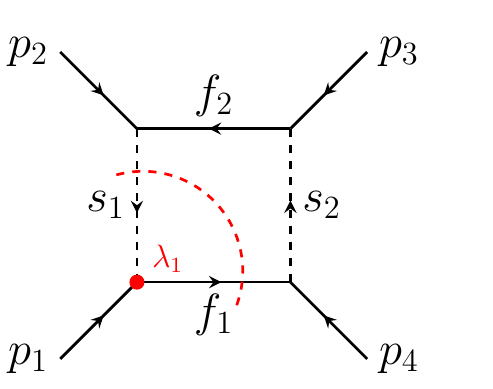
will automatically p 1 p 2 p 3 p 4 , O , O and O . See text for p 1 p 1 p 2 p 2 p 3 p 3 p 4 p 4